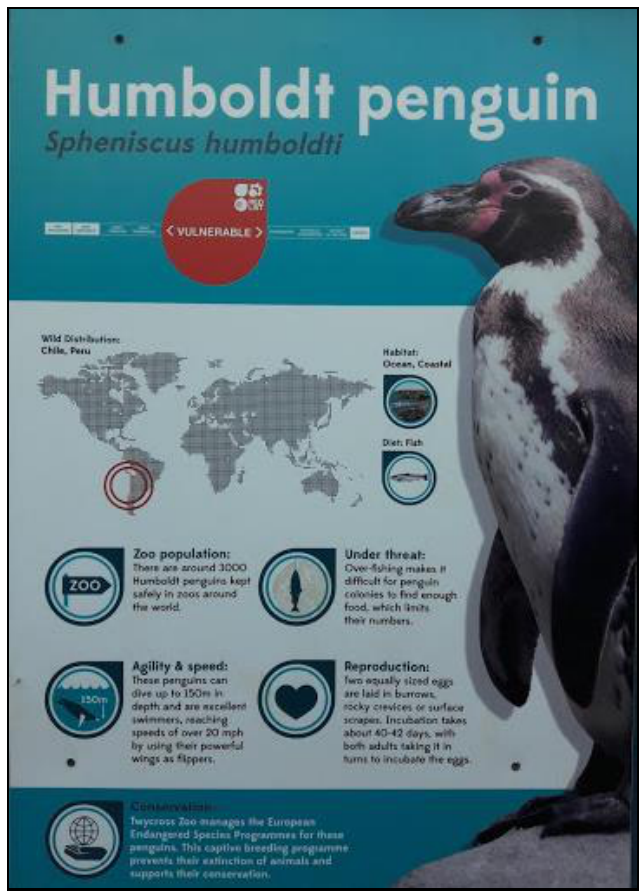
Figure 1. Interpretive signage available to all visitors at the Humboldt penguin enclosure at Twycross Zoo .